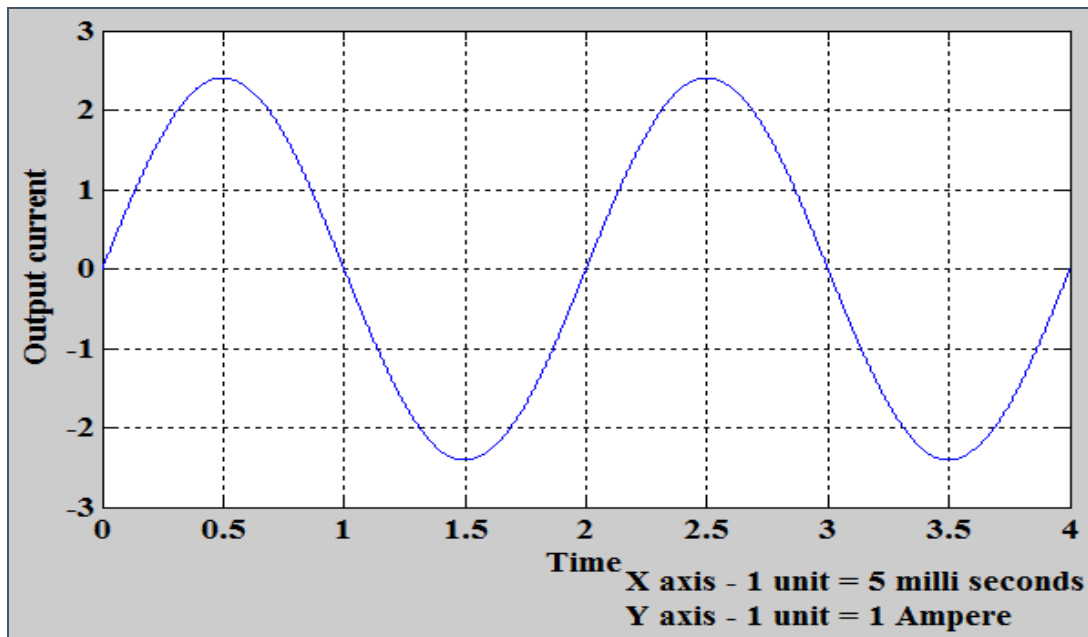
Figure 18. Output current vs. Time—R load (100 ohm)—Simulation.